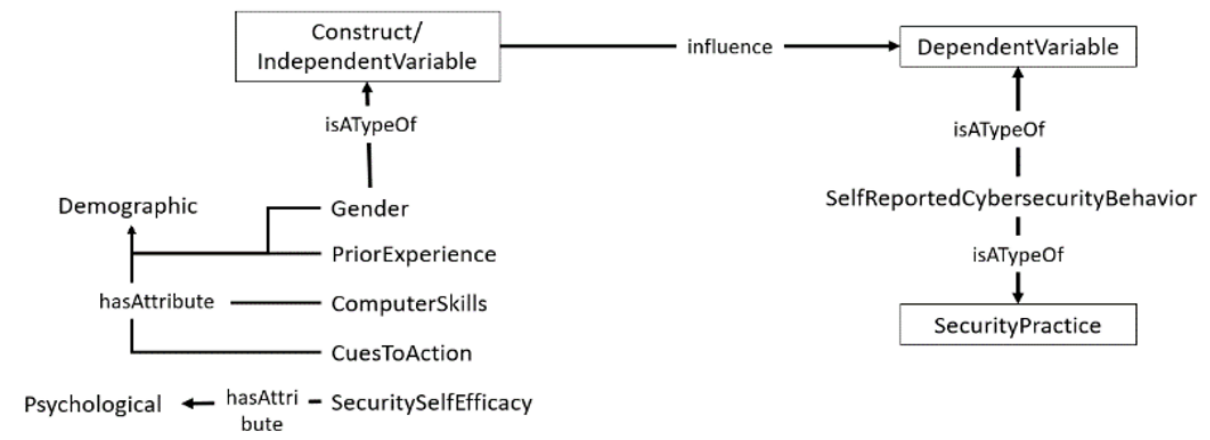
Figure 5. Expansion of the ontology based on results from a previous report